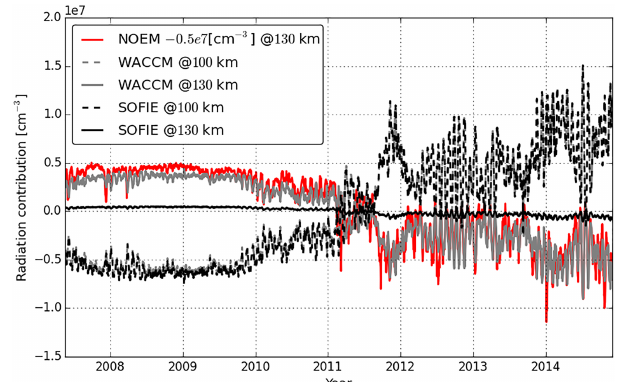
Figure 9. The contribution of Ly α radiation, as given by Eq. (4), to the NO budget for SOFIE (black) and WACCM (grey) at 100km (dashed) and 130km (solid) altitude. The solar contribution of NOEM at 130km is shown in red for comparison to WACCM, is offset by a factor of 5 × 10 6 cm − 3 and is based on the solar F10.7 radio